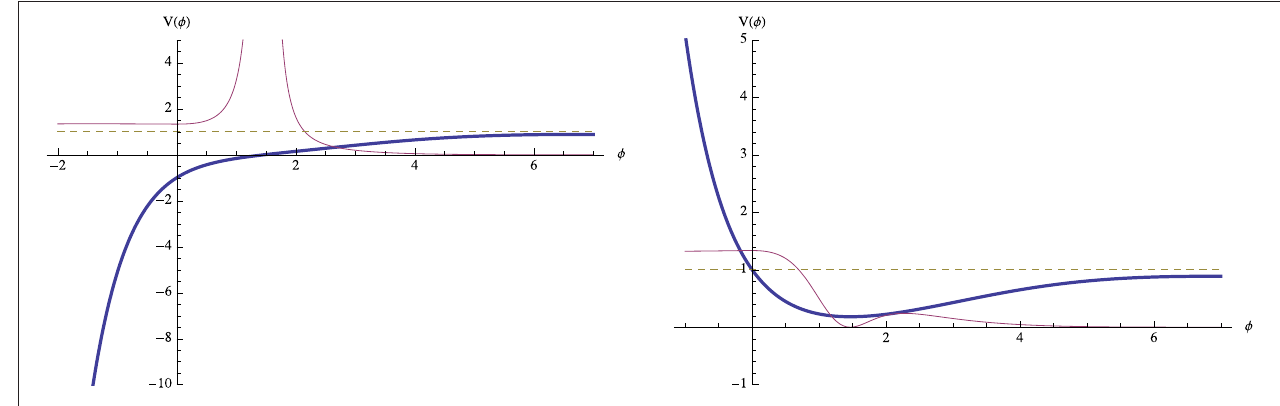
FIGURE 3 | Scalar potential V ( φ ) (blue thick line) and slow-roll function ǫ ( φ ) (red thin line) for α 10 and 3 2 (potential unbounded from below, left panel) and = − = − − t f such that ǫ ( φ ( t f )) 3 2 (potential with a minimum and V min > 0, right panel) [60, 111]. The slow-roll conditions are violated and inflation ends if 1 (thin dashed = ∃ = line) and ǫ ( φ ) > 1 for any t > t f . The dynamics induced by the potential V ( φ ) in the right panel keeps the dynamical field φ ( t ) in the region where ǫ ( φ ) < 1 [60, 111], − thus making it impossible to exit inflation by violation of the slow-roll conditions. The potential plotted on the left panel allows instead for a finite period of slow-roll inflation, but in this case the reheating of the universe after inflation cannot be described via the standard parametric oscillations of the inflation field.